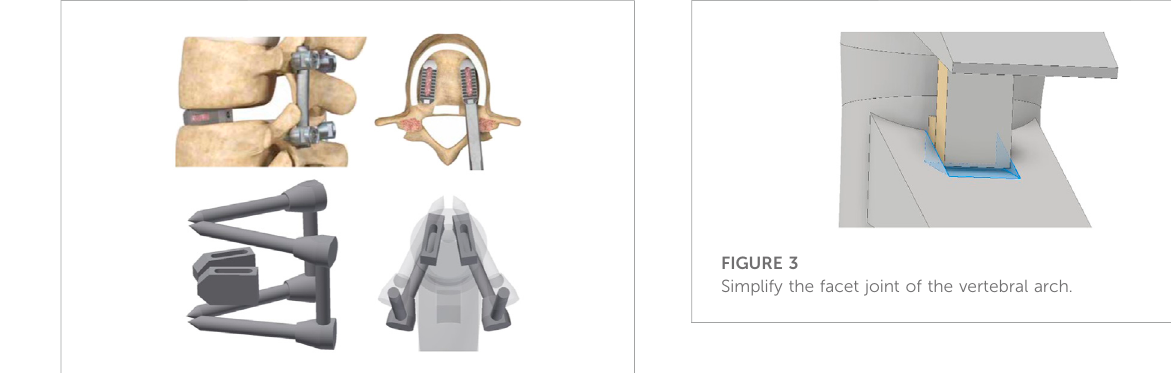
FIGURE 2 3D modeling that simulated LIF ’ s surgical method.